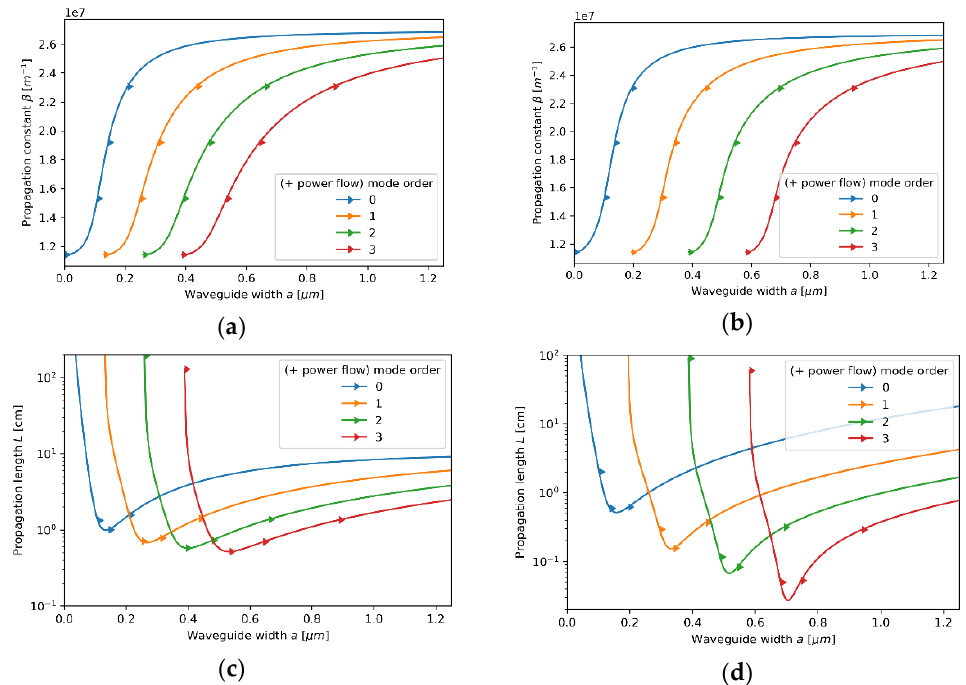
Figure 13. Propagation constant ( a , b ) and propagation length ( c , d ) of TM modes plotted versus waveguide width for an HMM waveguide with Nb2O5 layer of t Nb2O5 = 175 nm embedded in the unit cell and described with local ( a , c ) and nonlocal EMT ( b , d ).